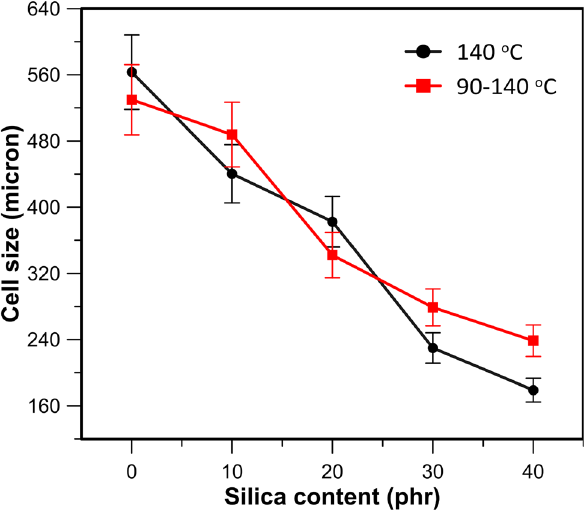
Figure 5: Variation of average cell diameter and its deviation in di ff erent foams.